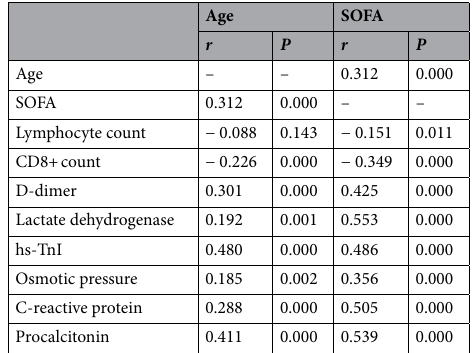
Table 4. Correlation of main laboratory findings with age and SOFA score in older adult patients with COVID-19. COVID-19, coronavirus disease 2019; hs-TnI, high-sensitivity troponin I; SOFA, Sequential Organ Failure